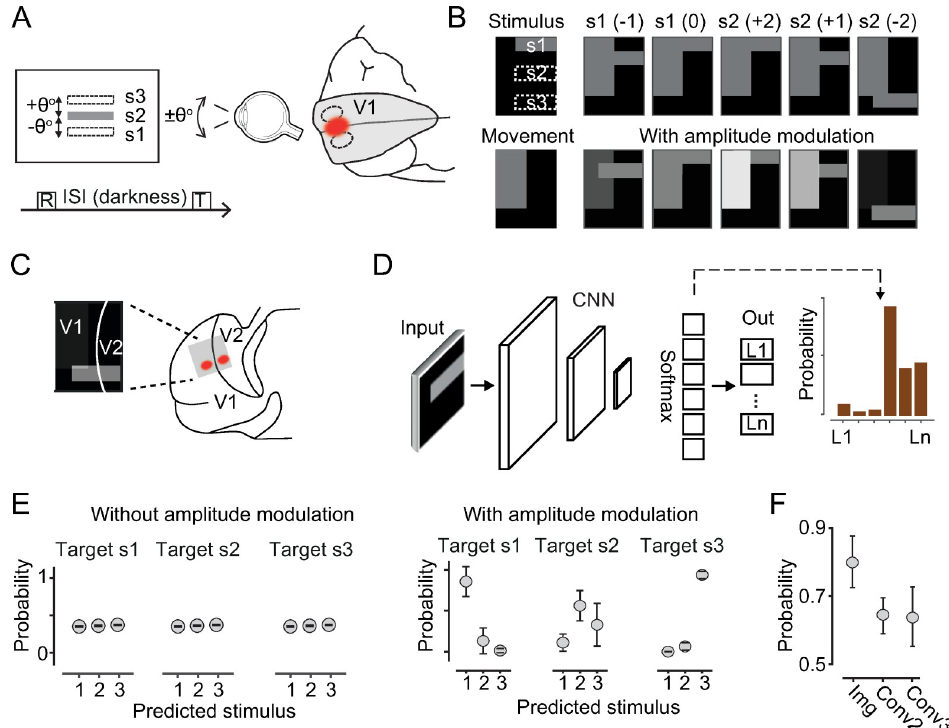
Fig 1. Corollary discharge signals enable localization invariance relative to image displacements. (A) Simulated psychophysical task. A participant is briefly shown a reference luminance bar (boxed “R” letter, and “S2” middle gray bar) and, after a delay in darkness (ISI), a test stimulus (T) is briefly presented either at the same elevation or ±θ ˚ from it (broken-line rectangles). During the ISI, the participant can make involuntary eye movements in the average range of ±θ ˚ as well. Eye movements produce shifts in retinal and cortical—primary visual cortex (V1)—activations associated with the stimuli (right, broken-line ovals; red spot for activations to the reference stimulus). (B) Example input images used to train the CNN, with or without amplitude modulations (bottom and top rows, respectively). Two leftmost panels show an example of stimulus and movement activity pattern in isolation (not used for training). The vertical rectangle represents activations linked to eye movements; the horizontal rectangle represents retinotopic activations to target stimuli presented at one of the three possible locations in visual space (s1, s2, s3, true labels, white broken-line rectangles in retinotopic space). Corresponding retinotopic activations can occur in one of five possible image (cortical) locations, depending on eye movements (Methods). In parentheses, discretized upward or downward eye movements. Top row, s1(0) is identical to s2(+2); similarly, s1(-1) is identical to s2(+1), exemplifying the ambiguity in location classification introduced by eye movements. Gray levels for bottom images in the [-1.3, +1.3] amplitude range; amplitudes are modulated upward or downward (0.2 steps) from a reference 0.5 value depending on saccadic direction. (C) Schematic of mirror-image activations at area borders in retinotopic regions, unique to visual activations, not observed with movement signals. (D) Basic components of the CNN architecture (also see Methods and S1 Fig). (E) The CNN fails to classify the location of the bar stimuli when the amplitude of the movement activations is constant (three left-most panels and panel (B ) , top). True labels in the titles; predicted locations on the x- axis labels. However, when movement activations are modulated by the magnitude of the eye movements, the CNN can solve the task (three right-most panels and panel (B ) , bottom). (F) Classification probability for movement signals added as a global scalar at different stages of the convolutional architecture (Methods; S1 Fig; error bars, s.d., n = 20 network